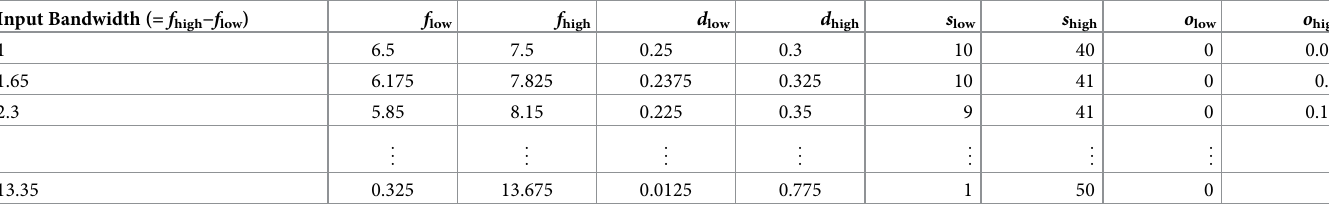
Table 5. Varied pulse input ( I VP ) parameters (see Methods: Phase-locking to rhythmic and quasi-rhythmic inputs: Inputs for details). Input Bandwidth (= f high − f low ) f